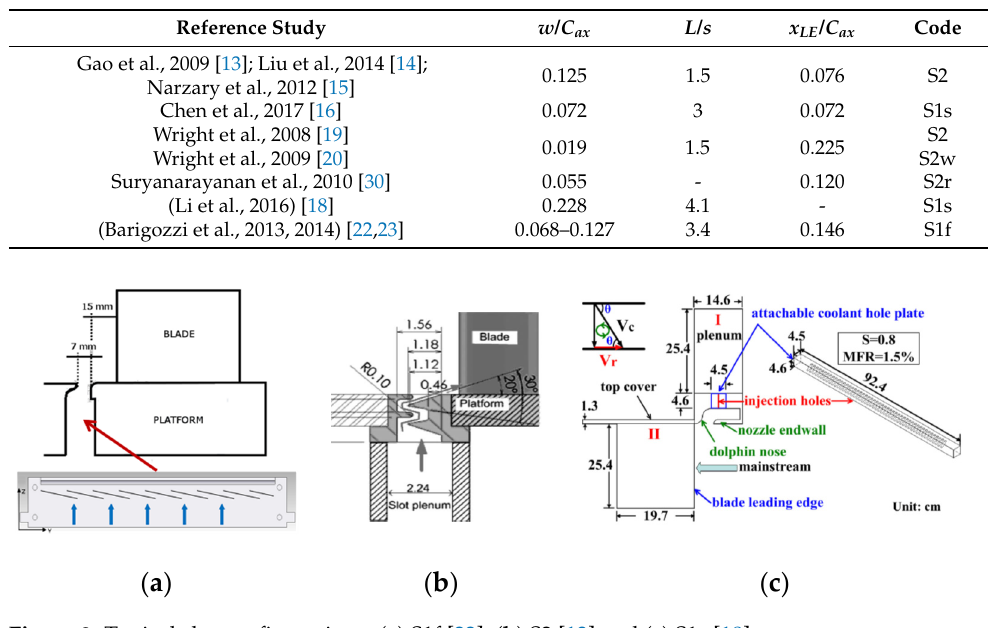
Figure 2. Typical slot configurations: ( a ) S1f [22], ( b ) S2 [13] and ( c ) S1s [18]. Table 1. Typical slot geometry and details of purge flow supply system.